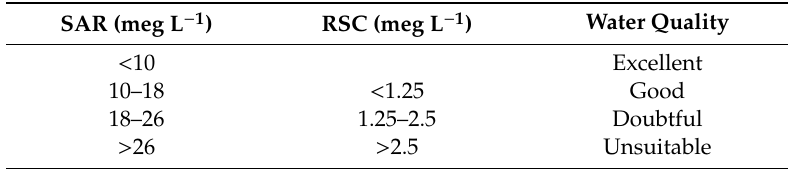
Table 5. Water quality suitability based on Sodium Adsorption Ratio (SAR) and Residual Sodium Carbonate (RSC) indices. Data adapted from